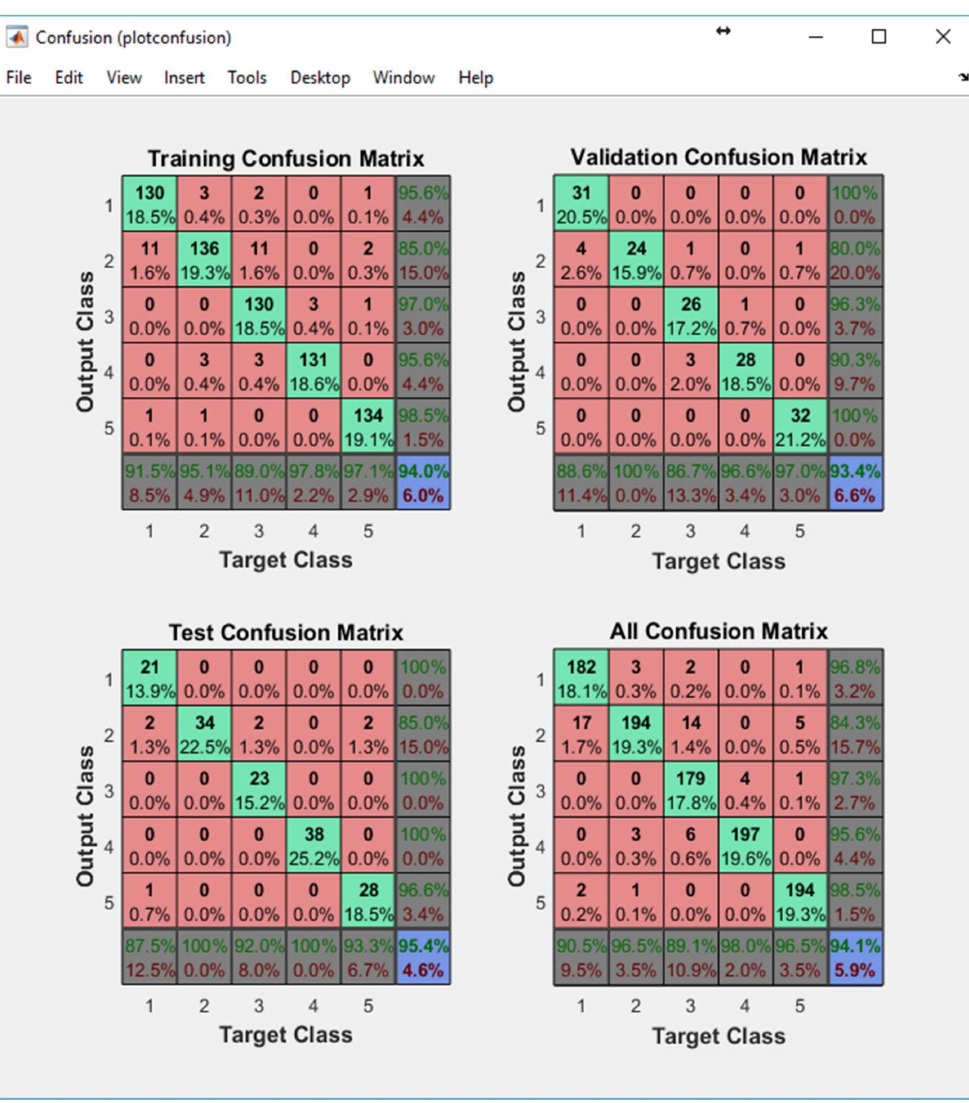
Figure 9. Plots of Training, Validation, Test and All Confusion